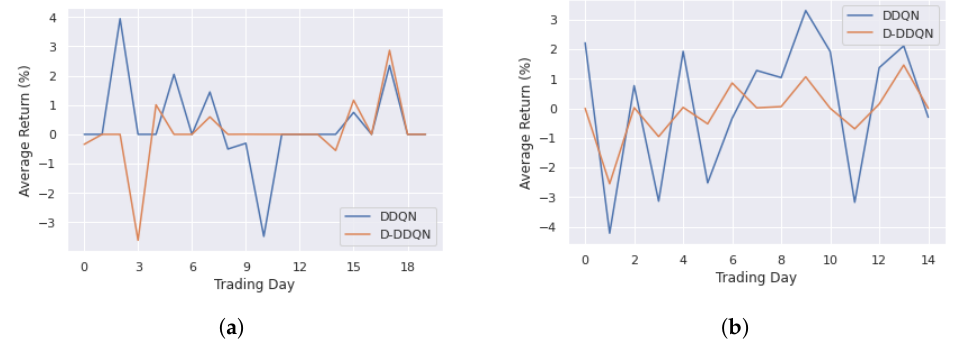
Figure 4. Average returns from DRL approach with return reward function. ( a ) Training period; ( b ) Testing